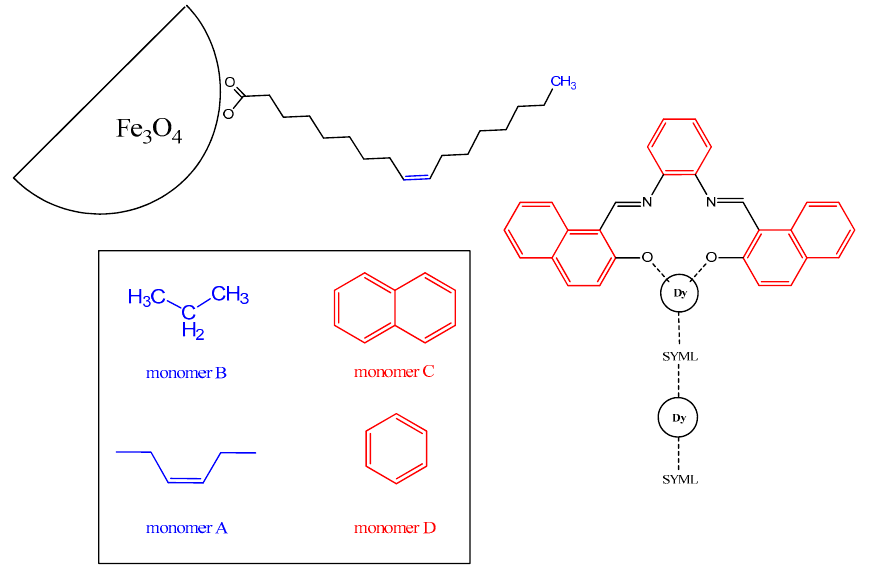
Figure 8. Schematic representation of the oleic acid monolayer-Dy complex interface, with the corresponding units that can interact with each other.